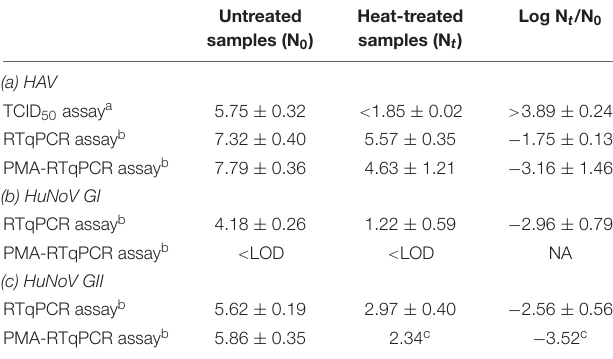
TABLE 2 | Titers and log reductions (average ± standard deviation) for hepatitis A virus (HAV), HuNoV GI, and GII in clams during heat inactivation. Untreated samples (N 0